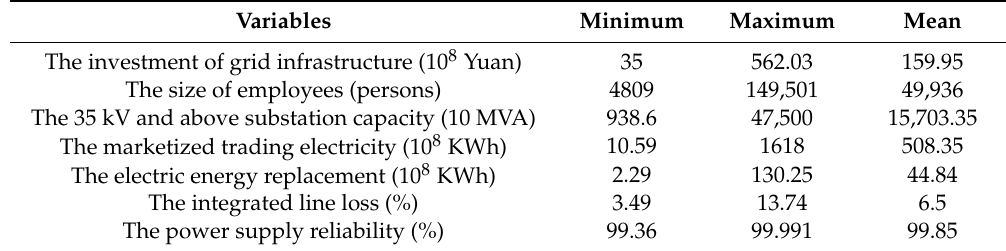
Table 1. Descriptive statistics of selected variables for 31 provincial PGEs.